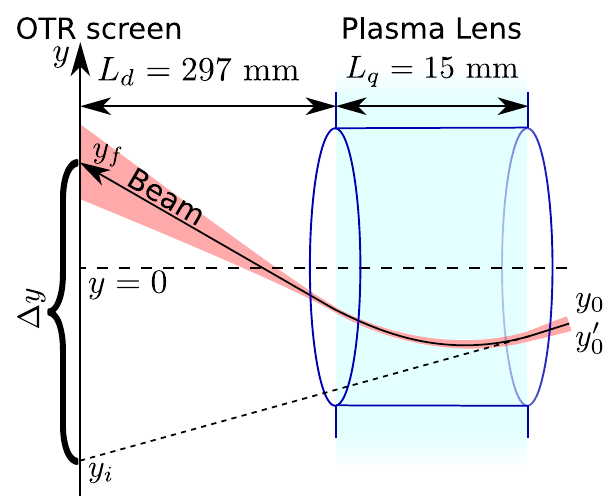
FIG. 3. Definition of variables used in discussion of thick-lens gradient